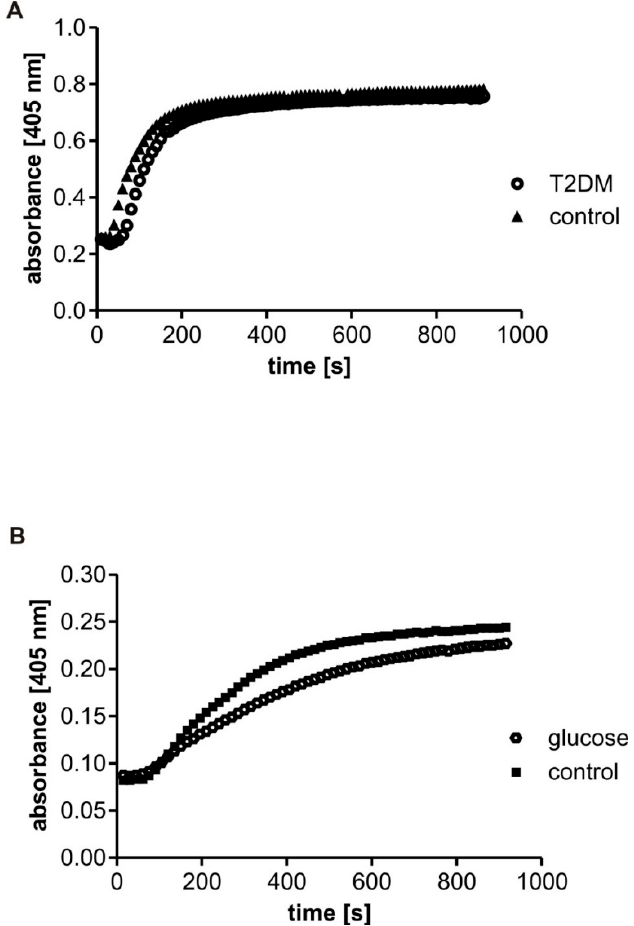
Figure 1. Representative curves of fibrin polymerization in plasma and in fibrinogen solutions Polymerization was monitored in plasma from control subjects (triangles) and diabetic patients (circles) ( A ) and in the solutions of fibrinogen incubated in vitro with PBS (squares) or 30 mM glucose for four days (37 °C, mixing 300 rpm/min)) (hexagons) ( B ).